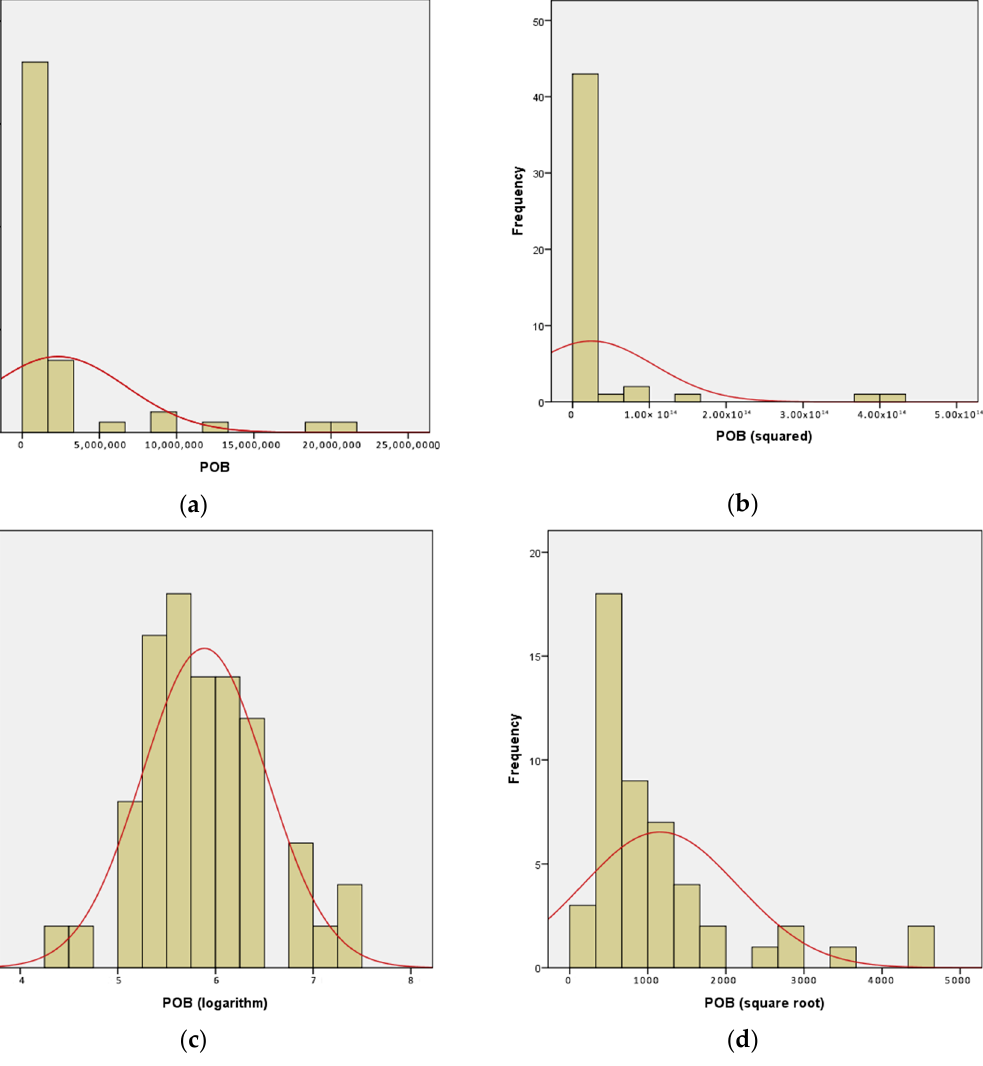
Figure 2. Histogram of the population variable (POB) and its transformations compared to a normal distribution. ( a ) Nontransformed variable. ( b ) Square transformation. ( c ) Logarithmic transformation. ( d ) Square root transformation.